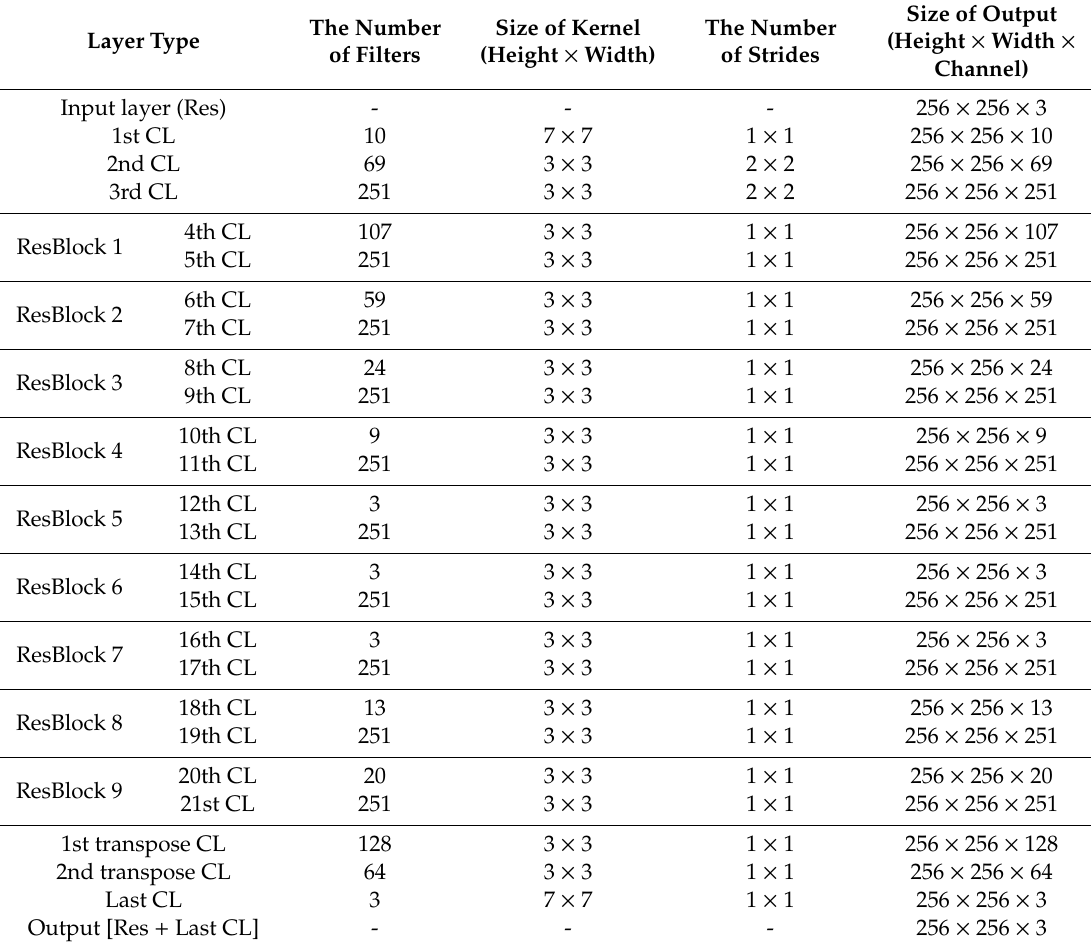
Table 3. SlimDeblurGAN: DeblurGAN generator architecture after the model pruning process (CL—convolutional